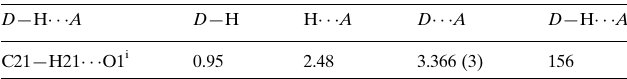
Hydrogen-bond geometry (A˚ , (cid:2)